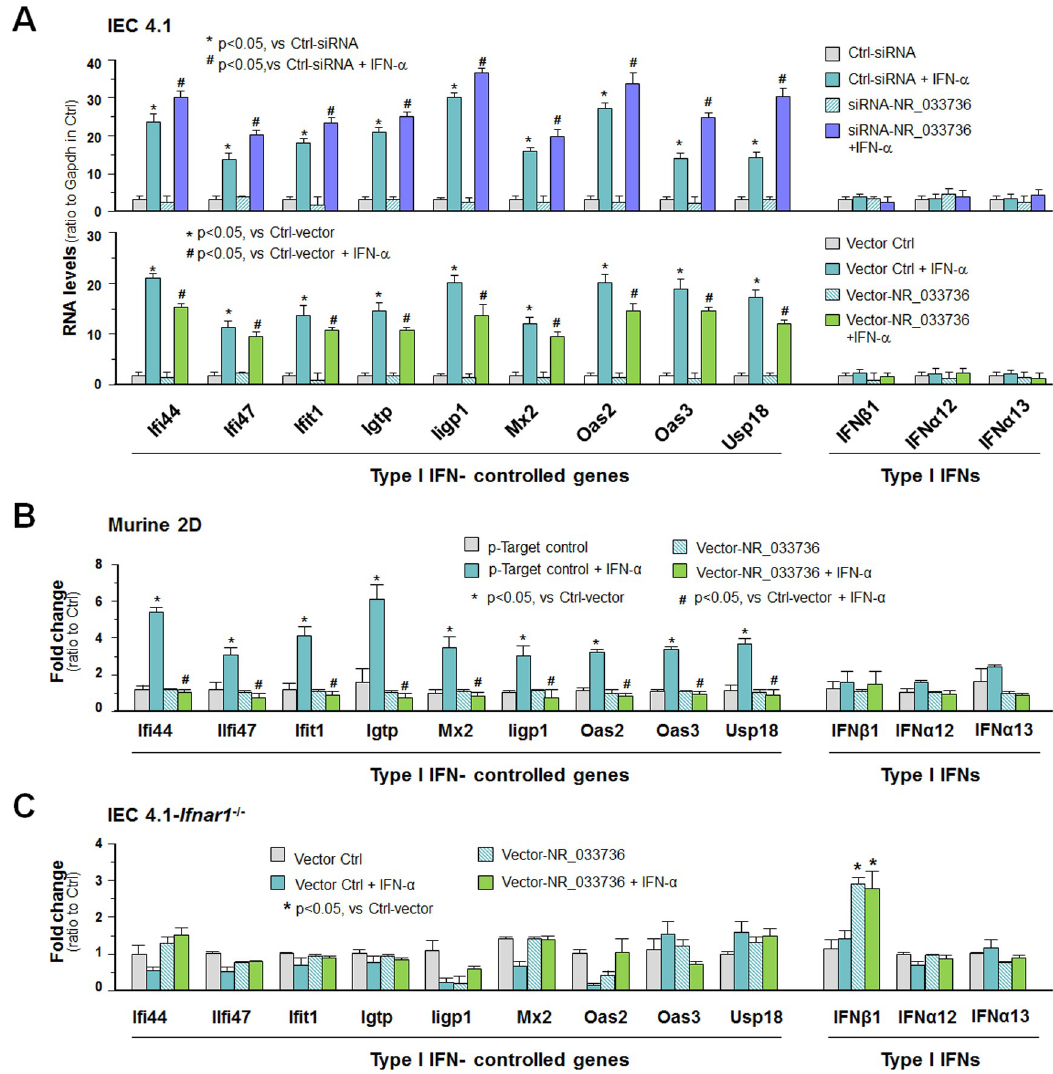
Fig 4. NR_033736 modulates type I IFN-mediated gene transcription in intestinal epithelial cells in response to IFN- α stimulation. (A) Effects of NR_033736 expression levels on IEC4.1 cell response to IFN- α stimulation. Cells were treated with the siRNA or transfected with the vector expression NR_033736 (Vector-NR_033736) for 24 h and then exposed to IFN- α stimulation for 2 h. Expression levels of type I IFN-controlled genes and selected type I IFN genes were validated by using qRT-PCR. Cells treated with the non-specific scrambled siRNA (Ctrl-siRNA) or the empty vector (Vector-Ctrl) were used for control. (B) Overexpressing NR_033736 attenuated the induction of type I IFN-controlled genes in murine intestinal epithelial 2D monolayers in response to IFN- α stimulation. The crypt units of small intestinal epithelium from neonates of 5 days old were isolated and cultured into 2D monolayers. Epithelial monolayers were then transfected with the Vector-NR_033736 for 24 h followed by exposure to IFN- α stimulation for 2 h. Expression levels of type I IFN-controlled genes and selected type I IFN genes were validated by using qRT-PCR. Monolayers transfected with the Vector-Ctrl were used for control. (C) Expression of type I IFN-controlled genes in IEC4.1 cells with deficient in Ifnar1 in response to IFN- α stimulation. Cells were transfected with the Vector-NR_033736 for 24 h and then exposed to IFN- α stimulation for 2 h. Expression levels of type I IFN-controlled genes and selected type I IFN genes were validated. Data represent three independent